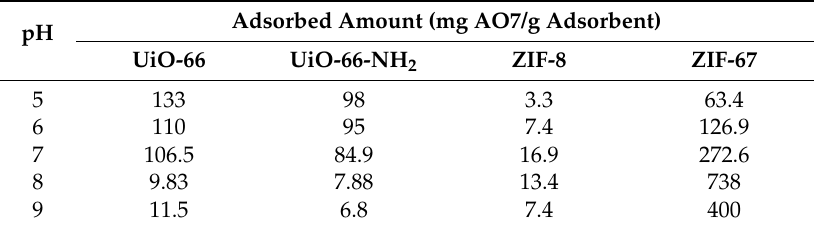
Table 1. Effect of pH on adsorption of AO7 on MOFs.